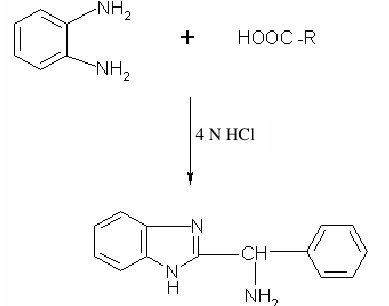
Figure 1. Preparation of benzimidazole derivatives.